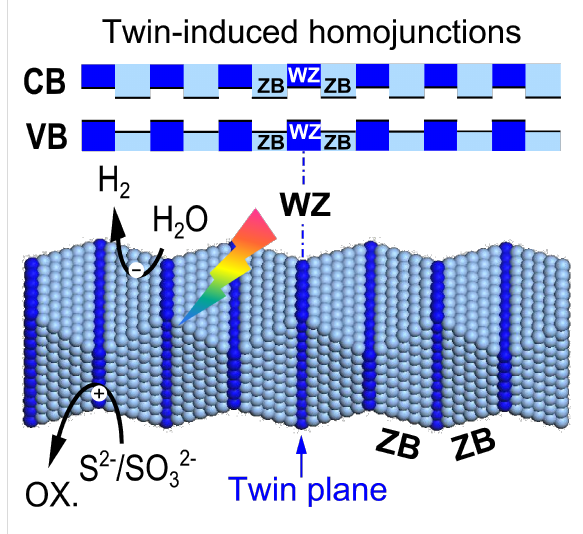
Figure 10: Illustration of twin-induced 1D long range ordered homo- junctions over Cd 0.5 Zn 0.5 S with alternative zinc-blende (ZB) and wurtzite (WZ)